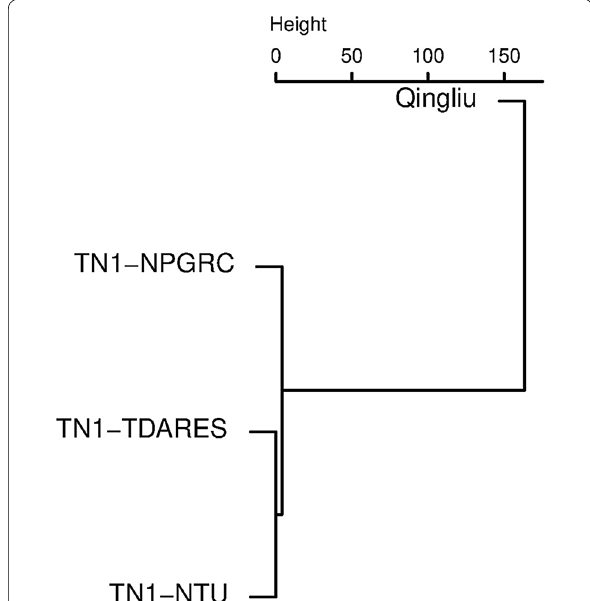
Fig. 2 Hierarchical clustering of Qingliu and three accessions of the Taichung Native 1 (TN1) rice variety based on Euclidian distance calculated from 43,325 genome‑wide SNPs